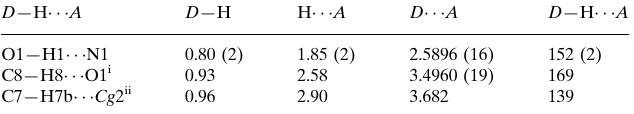
Hydrogen-bond geometry (A˚ , (cid:1) ). Cg 2 is the centroid of the C9–C14 ring.